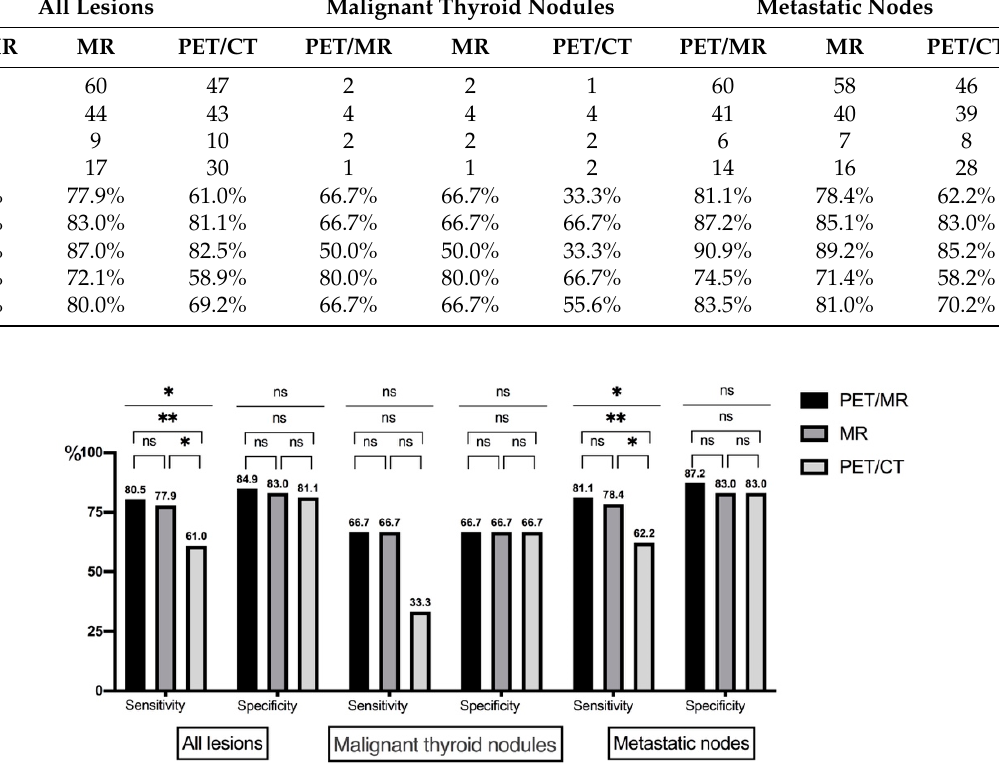
Figure 4. Diagnostic performance of two modalities (ns represents no significance; * represents the p -value < 0.05; ** represents the p -value < 0.01). The image clarity scores for each region of the lesion are shown in Table 4. For all included lesions, the PET/MR scores were significantly higher than those of PET/CT (2.74 ± 0.60 vs. 1.9 ± 0.50, p < 0.001). The largest score was in level II (2.92 ± 0.33), which almost exceeded PET/CT (1.91 ± 0.45) by 1 point. For malignant lesions, there was no difference between PET/MR and PET/CT in the assessment of suspected thyroid nodules, while there were significant differences in the assessment of metastatic lymph nodes of all levels. The largest differences between PET/MR and PET/CT occurred in level II (2.83 ± 0.48 vs. 1.79 ± 0.58) and level V (2.73 ± 0.67 vs. 1.85 ± 0.46), as presented in Figure 3. For benign lesions, PET/MR had better presentation of thyroid nodules and lymph nodes in other